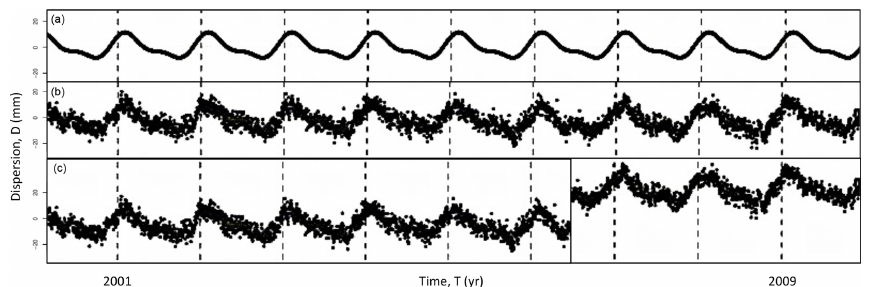
Figure 1. Decomposition of an example synthetic time series: (a) seasonal (annual and semiannual) signals; (b) seasonal signals combined with random colored noise; (c) seasonal signal, colored noise, and a simulated offset (vertical black line).